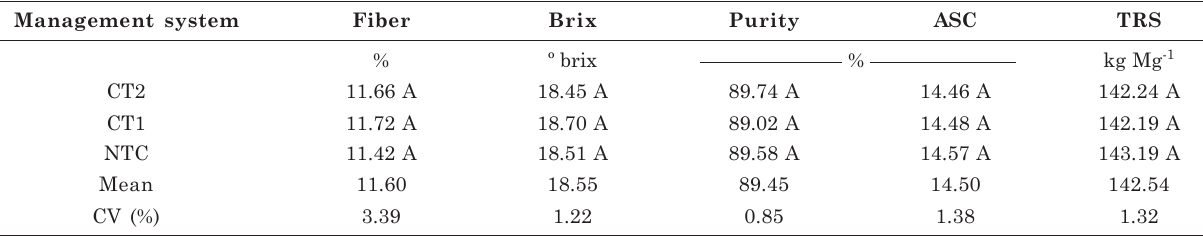
Means followed by the same capital letter in the column did not differ statistically (p<0.05). Fiber: cane fiber; Brix: total soluble solids; Purity: cane juice purity; ASC: apparent sucrose content; and TRS: total recoverable sugars.